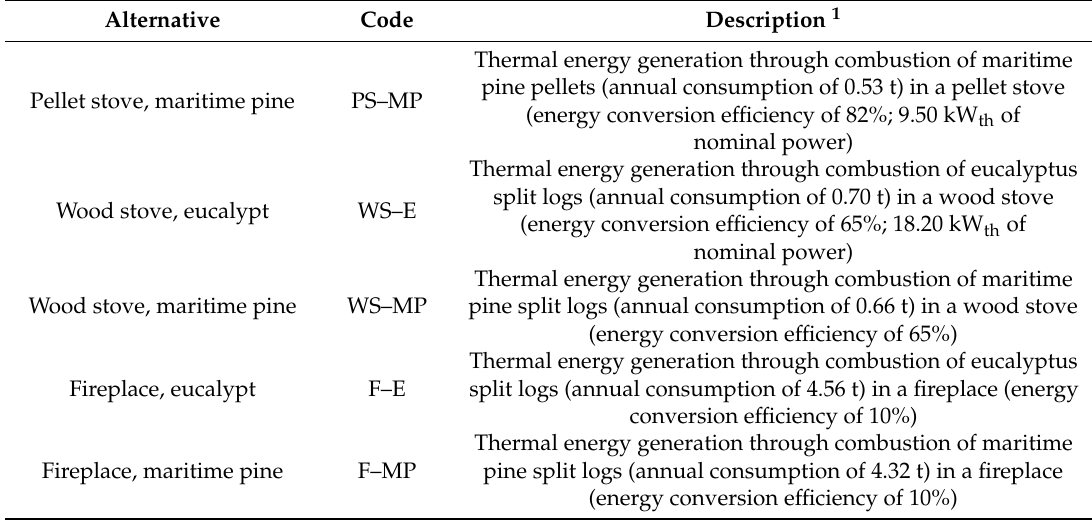
Table 1. List of wood-based alternatives residential heating considered in the multi-criteria decision analysis (MCDA)